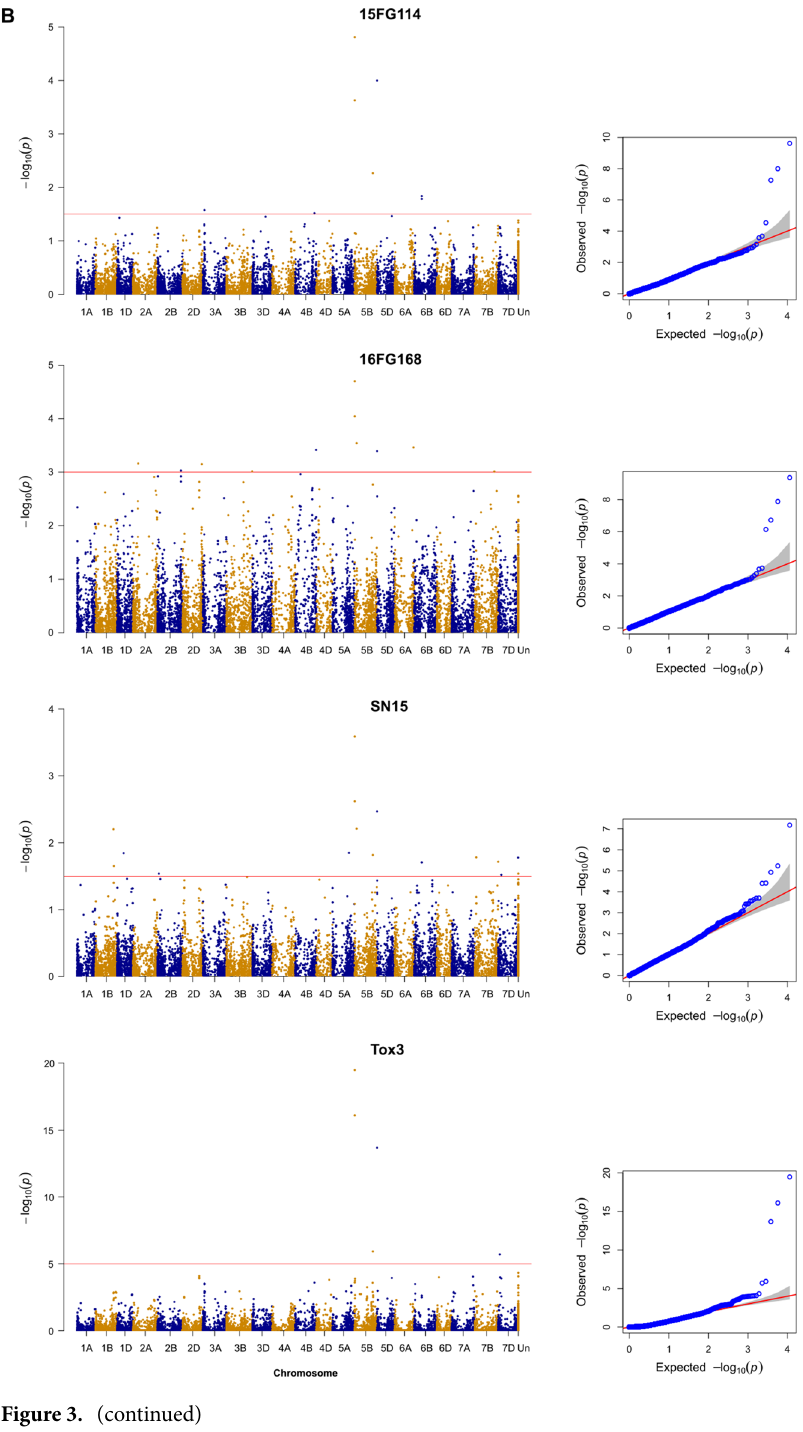
Figure 3. pathogenicity potential and their disease profile’s components of the five groups on exotic wheat lines derived from CIMMYT and the Vavilov collection. This information will help to create management strategies and to breed for durable SNB resistance. SNB inoculation assays carried out with five representative isolates from the five sub-populations found in Australian P. nodorum population on a wheat panel showed that they are different in pathogenicity potential. The panel has been chosen so that ToxA– Tsn1 and SnTox1– Snn1 interactions were removed to reduce disease complexity and increase chances of detecting novel interactions. Marker-trait association analysis revealed dis- tinct QTL/MTA profiles that consist of different genomic regions associated with their disease severity (Table 2). Isolates from core group 1 (15FG114, Table 1) followed by transient groups 5 and 3 (16FG168 and SN15, Sup- plementary Fig. 1) were the most pathogenic. QTL profiles of these three isolates were almost distinct except 1D